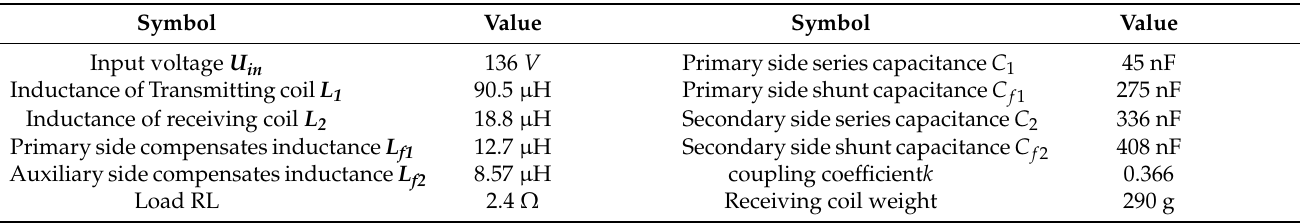
Figure 18. System experimental test platform. Table 2. WPT system parameters .